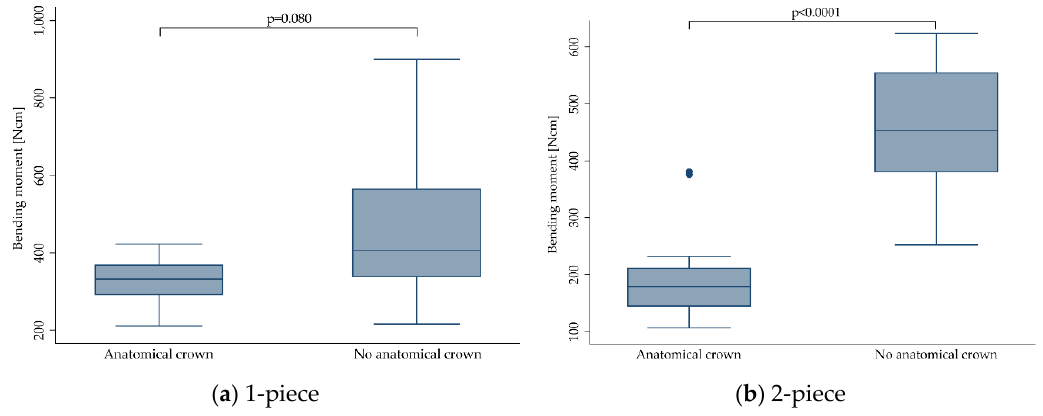
Figure 6. Boxplots showing the bending moment at the time point of fracture depending on the crown supply for 1- ( a ) and 2-piece ( b ) zirconia implants. Whiskers are used to represent all samples lying within 1.5 times the interquartile range. Dots represent outliers. Detailed data can be found in Tables 3 and 4.